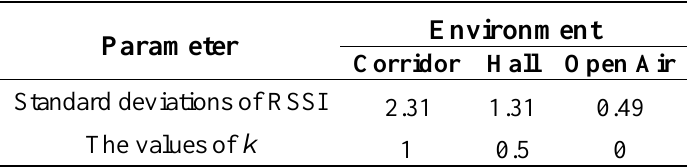
Table 3. The experimental parameters and